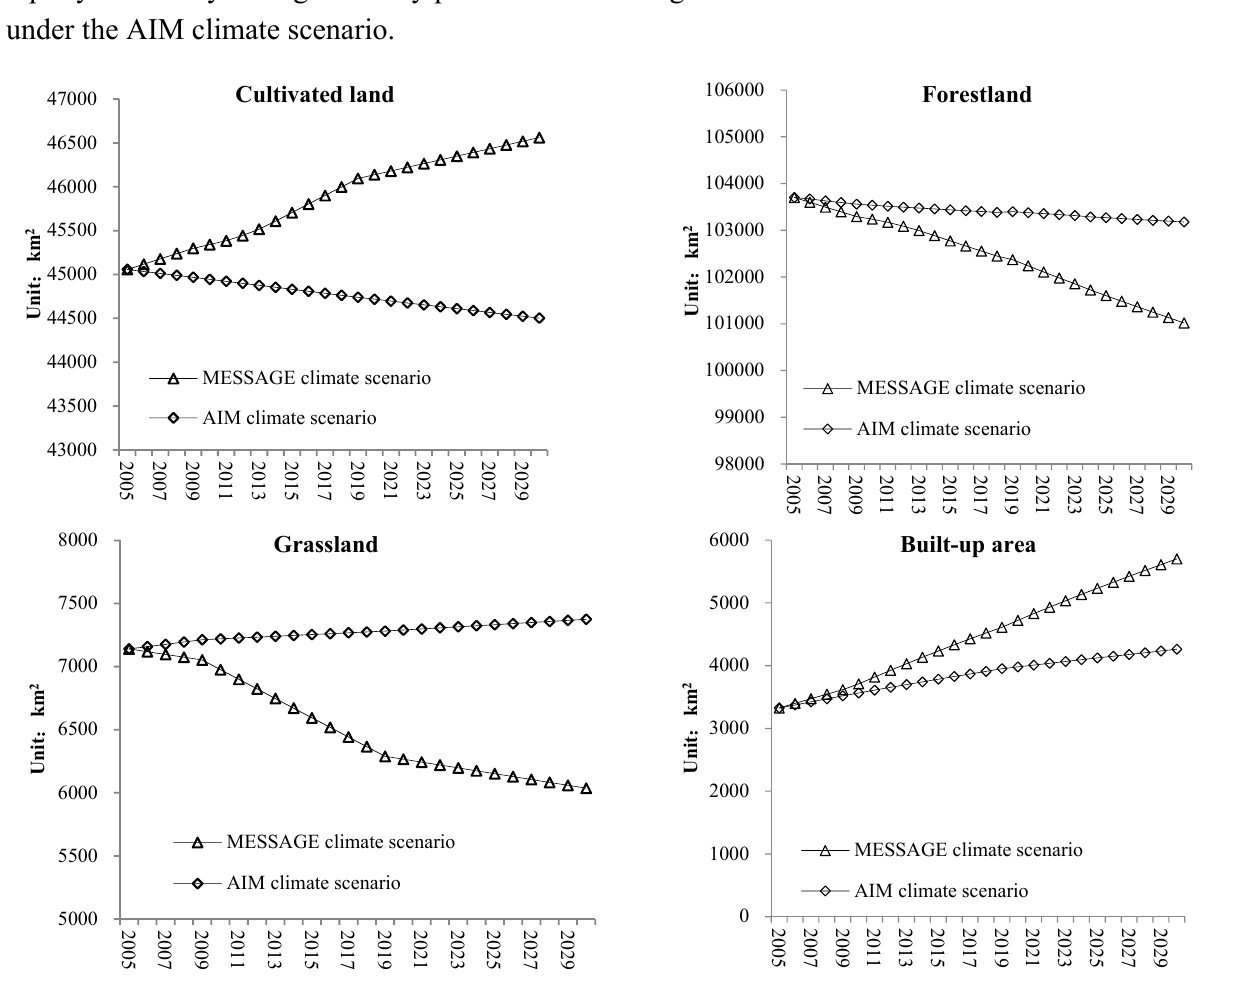
Figure 3. Land use structure under the climate scenario. AIM: Asia-Pacific integrated model; MESSAGE: model for energy supply strategy alternatives and their general environmental